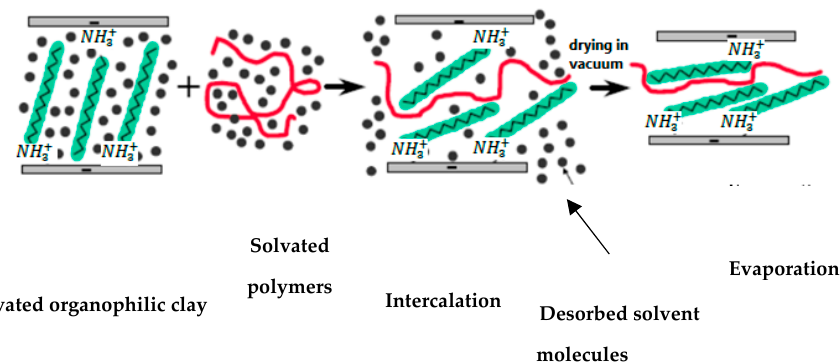
Figure 6. Solution blending technique for the preparation of polymer/clay nanocomposites.